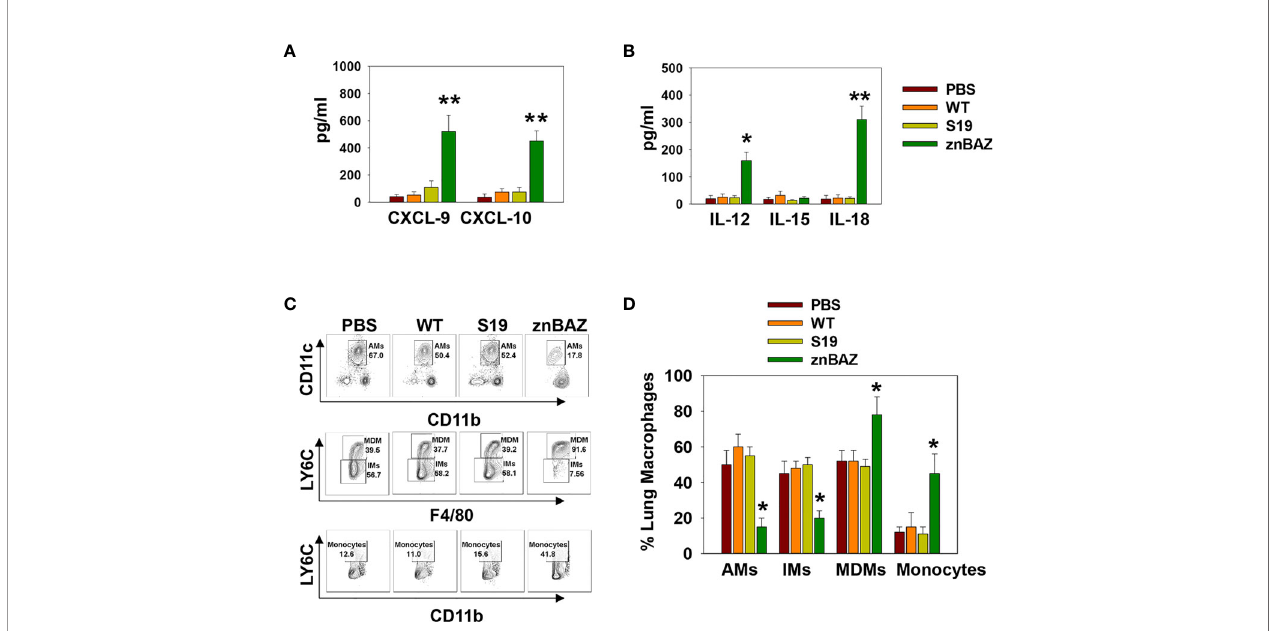
FIGURE 2 | Lung monocytes and macrophages produce CXCR3 ligands, CXCL-9 and CXCL-10, and NK cell-activating cytokines, IL-12 and IL-18, subsequent to nasal znBAZ infection. Groups of BALB/c mice were nasally dosed with wild-type B. abortus 2308 (WT), B. abortus S19 vaccine, or znBAZ, and three days later, (A) CXCR3 ligands, CXCL-9 and CXCL-10, and (B) NK cell activating cytokines, IL-12, IL-15, and IL-18, present in individual bronchoalveolar lavage (BAL) fl uids, were measured by cytokine-speci fi c ELISA. (C, D) Total mononuclear cells were isolated from the lungs to measure the frequency of lung monocytes and macrophages including alveolar macrophages (AMs), interstitial macrophages (IMs), monocyte-derived macrophages (MDMs), and monocytes by fl ow cytometry. The data depict the means ± SEM of 5 mice/group; *p < 0.01 and **p ≤ 0.001, compared with sPBS-dosed mice. Data are representative of two or three